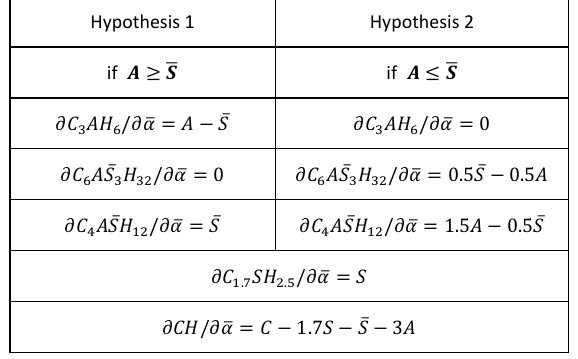
Table 2. Stoechimoetry hypothesis for portland cement hydration.